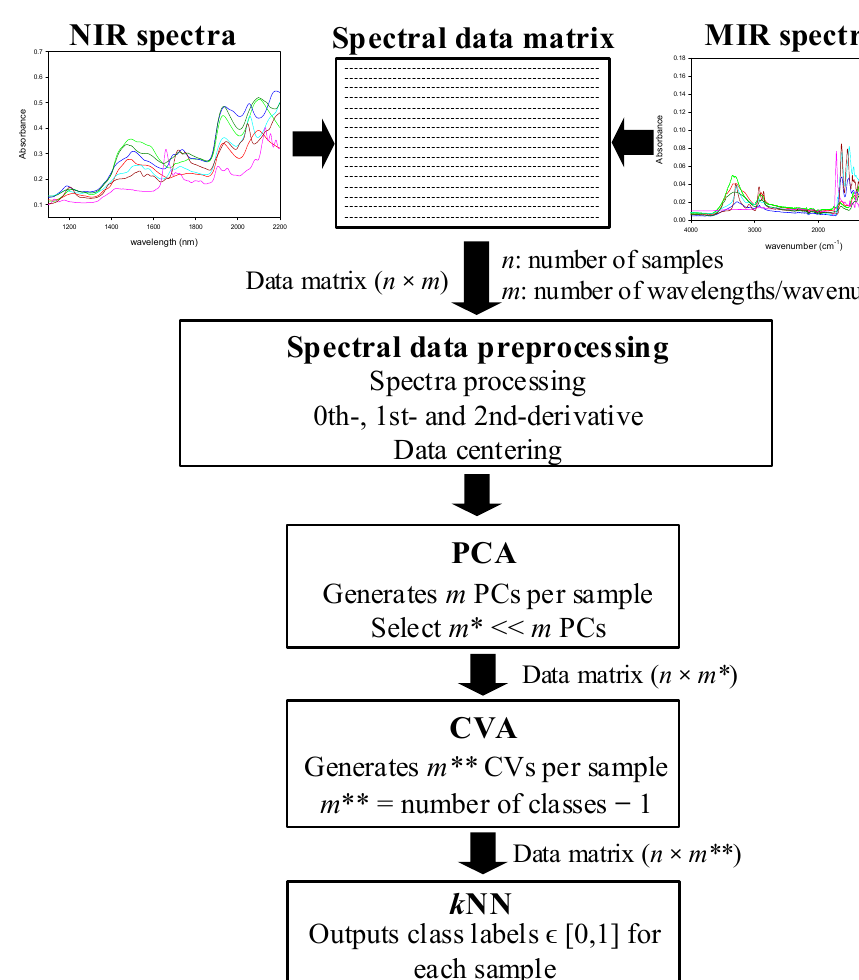
Figure 1. Diagram of classification strategy applied to spectral data for classifying unknown incoming fiber samples according to pre-established classes of textile fibers.